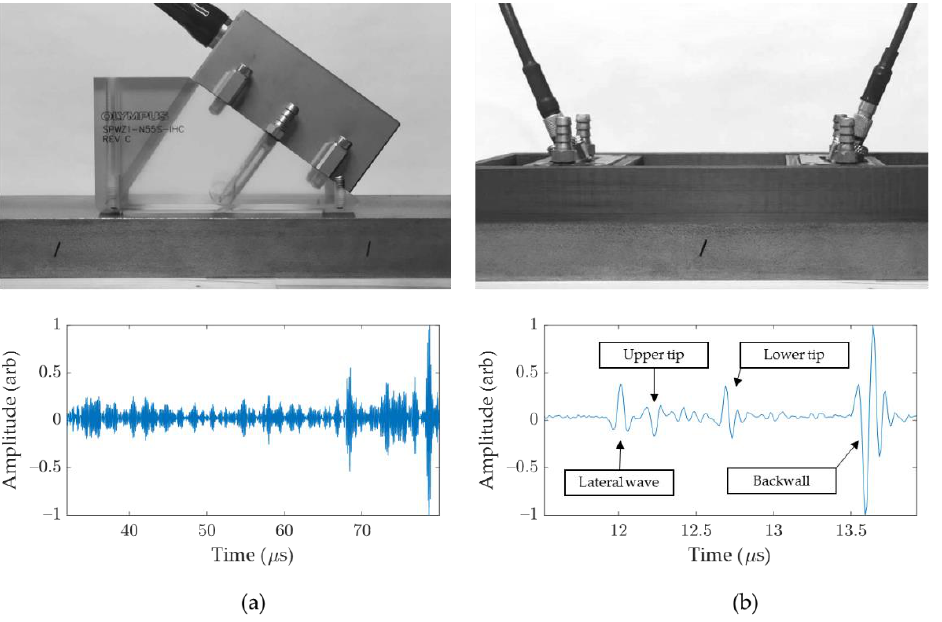
Figure 10. Measurement setup, and typical signal acquired signal for IPCI ( a ) and TOFD ( b ).